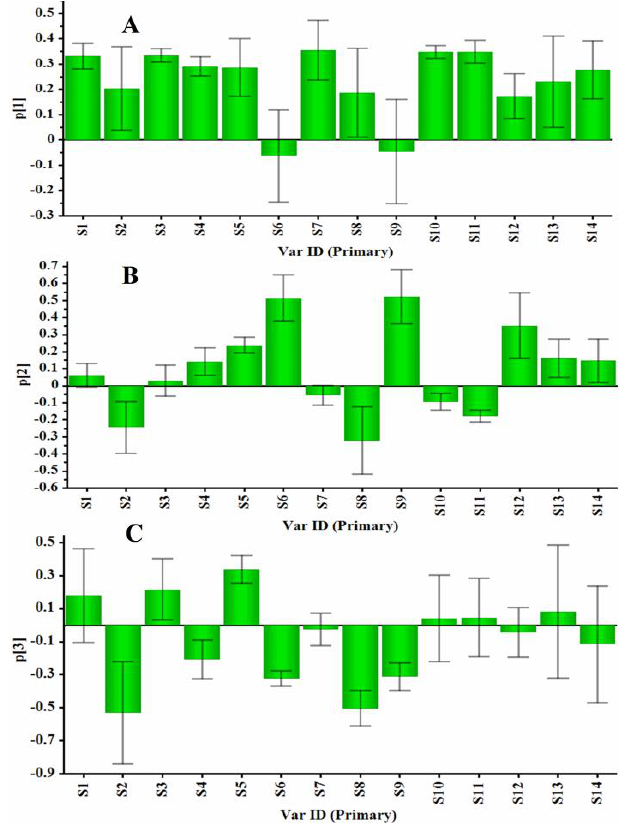
Figure 6. The influences of each variable on the first component ( A ), the second component ( B ), and the third component ( C ).